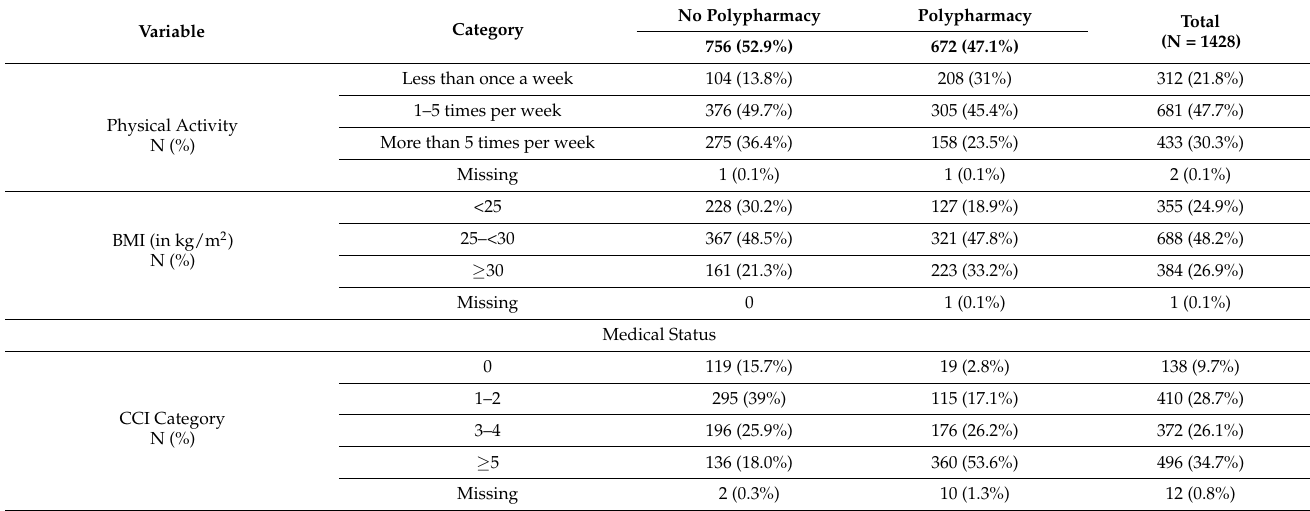
Figures 2 and S2 show the baseline distribution of SRH and the SRH change catego- ries in participants without polypharmacy (A) and those with polypharmacy (B). Com- pared to participants without polypharmacy, more participants with polypharmacy were in the stable moderate category (27.5 vs. 13.5%), stable low category (6.4 vs. 2.1%), decline category (30.5 vs. 26.9%), and the improvement category (16.2 vs. 11.4%). Conversely, more participants without polypharmacy were in the stable high category (46.2 vs. 19.3%).